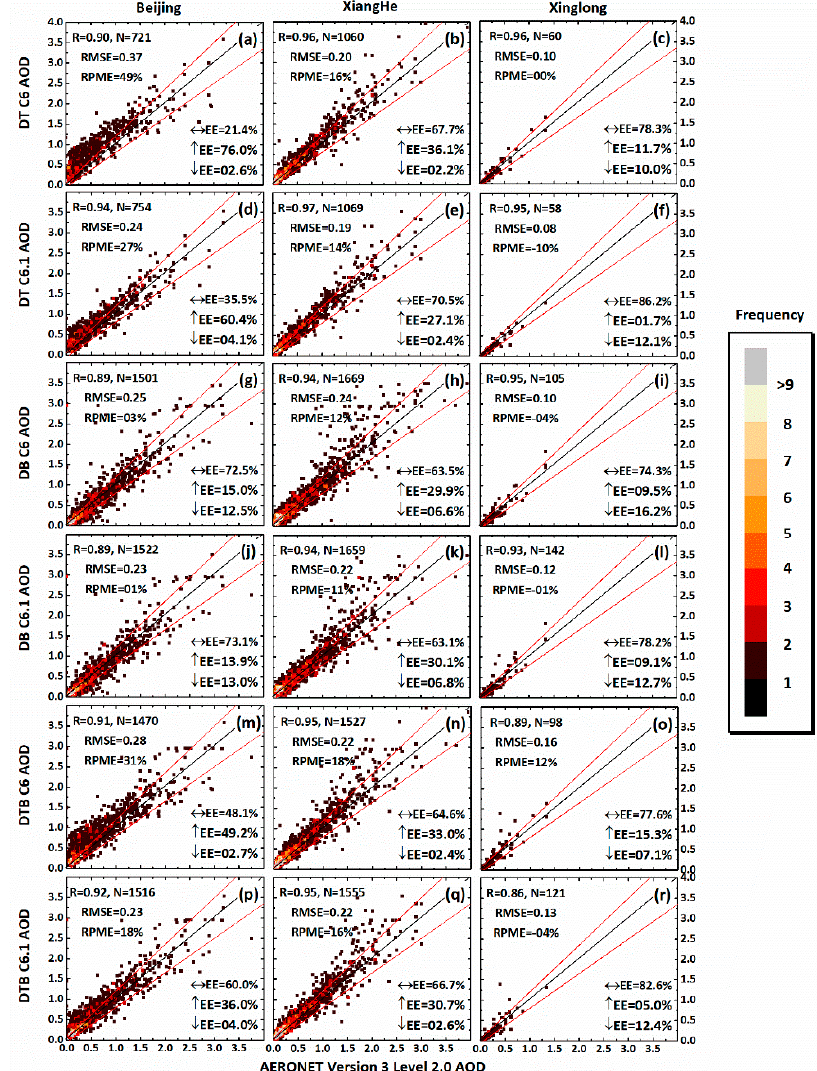
Figure 2. Validation of MODerate resolution Imaging Spectroradiometer (MODIS) aerosol optical depth (AOD) retrievals from 2004–2014 at the Beijing, XiangHe and Xinglong AERONET sites, including DT C6 ( a – c ), DT C6.1 ( d – f ), DB C6 ( g – i ), DB C6.1 ( j – l ), DTB C6 ( m – o ), and DTB C6.1 ( p – r ). The black line is the 1:1 line, and red lines are the expected error envelope.